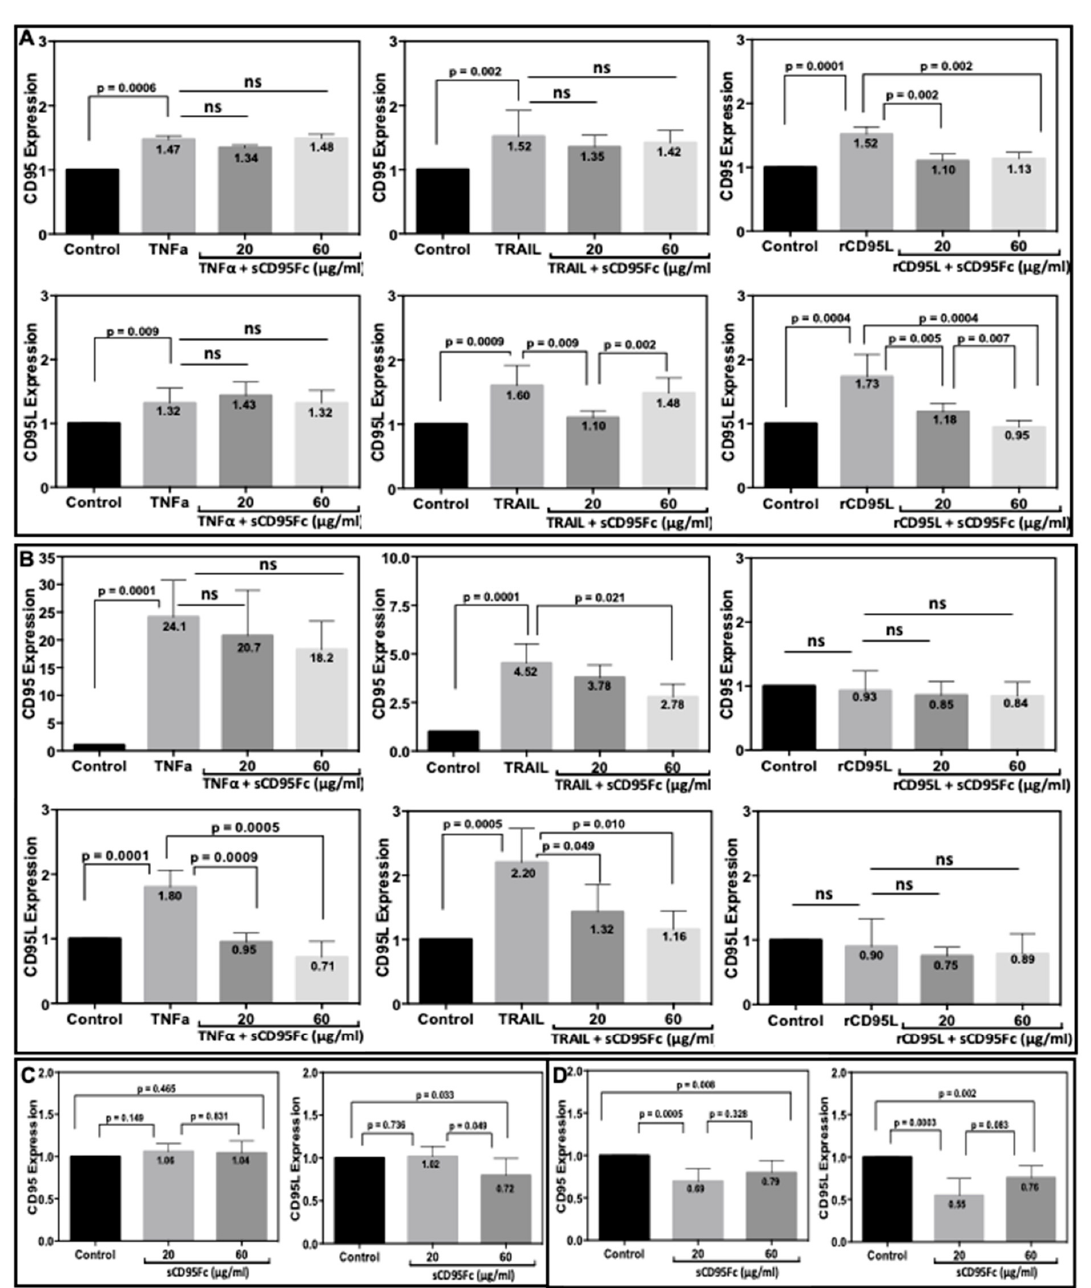
Figure 5. Inhibitory effects of sCD95Fc on CD95 and CD95L gene expression in pancreatic cancer cell lines upon TNF- α , TRAIL and rCD95L treatment. Human pancreatic cancer cells PancTuI-luc ( A , C ) and A818-4 ( B , D ) were seeded with 2.8 × 10 5 cells/well in 6-well plates. Cells were either left untreated (control; black bar) or stimulated with 50 ng/mL TNF- α or 50 ng/mL TRAIL or 100 ng/mL rCD95L (grey bar), TNF- α ± sCD95Fc (20 μ g/mL) or TRAIL ± sCD95Fc (20 μ g/mL) or rCD95L ± sCD95Fc (20 μ g/mL) (dark grey) and TNF- α ± sCD95Fc (60 μ g/mL) or TRAIL ± sCD95Fc (60 μ g/mL) or rCD95L ± sCD95Fc (60 μ g/mL) (light grey) or treated alone with sCD95Fc (20 μ g/mL; light grey) or (60 μ g/mL; dark grey) for 36 h. Cells were lysed in RNA Lysis Buffer T; total RNA was isolated and assayed for CD95 (upper row; A , B or left panel; C , D ) and CD95L (lower row; A , B or right panel; C , D ) by PerfectProbe realtime-RT-PCR Assay. Relative expression was normalized to the control and reference genes UBC or RPL13A and expressed as arbitrary unit (AU). Controls were set as 1 in each experiment and normal distribution of the data was tested by the Shapiro–Wilk method. p -values indicate statistical significance levels, while non-significant data represented by ns.). Data represent means ± SEM of biological replicates ( n = 3).